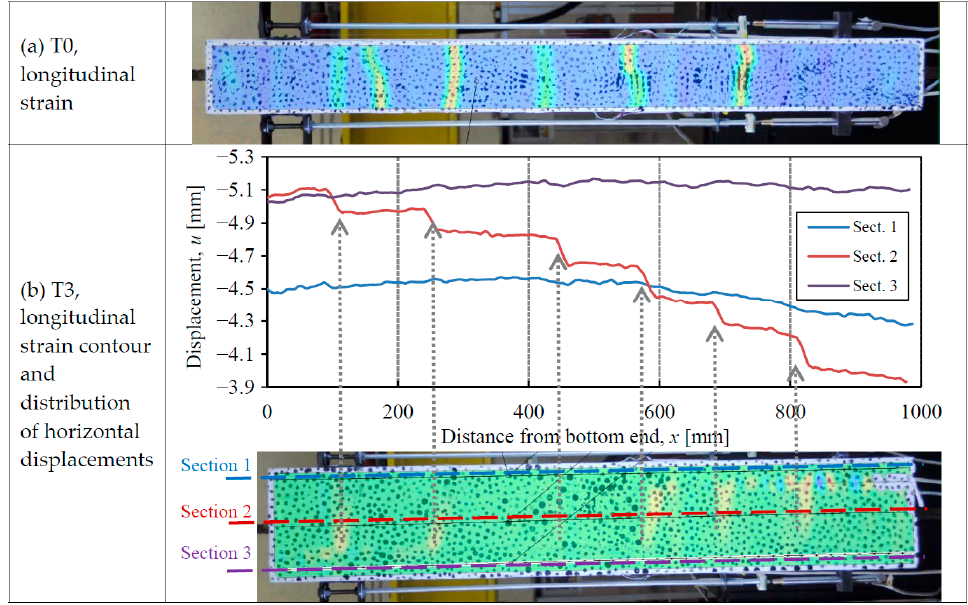
Figure 8. Crack detection with the help of DIC ( a ) With longitudinal strain contour (specimen T0, F = 40 kN); ( b ) Longitudinal strain contour supported by horizontal displacements (specimen T3, F = 45 kN).